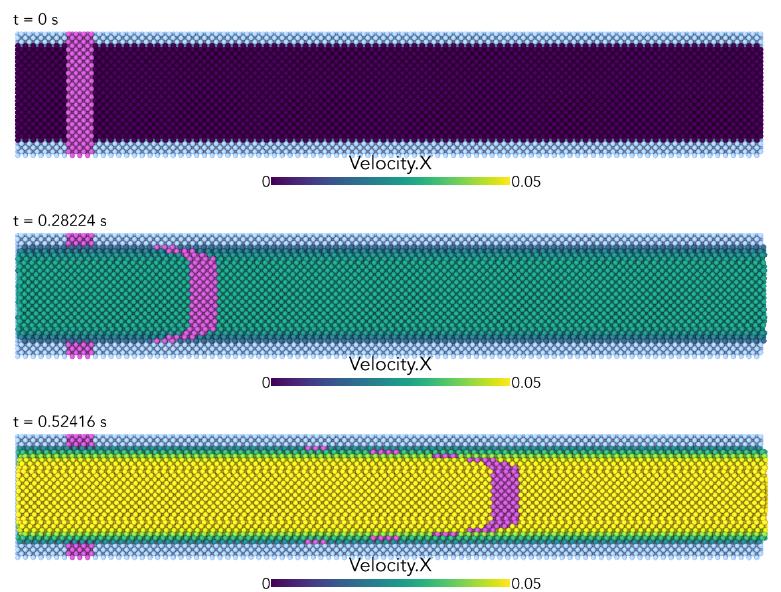
Figure 24. Evolution of timelines (tracking particles) in the pipe for response type “Bingham flow”.